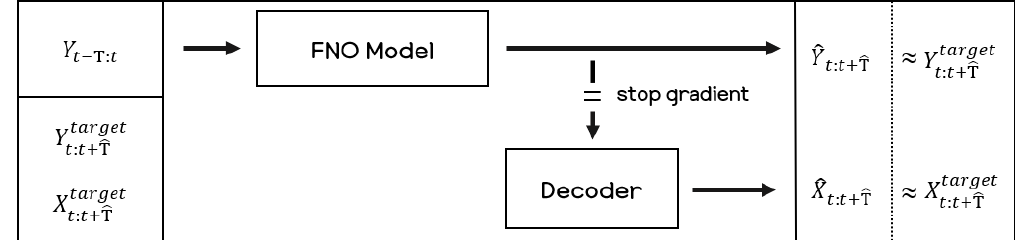
Figure 4. Block diagram for training the proposed